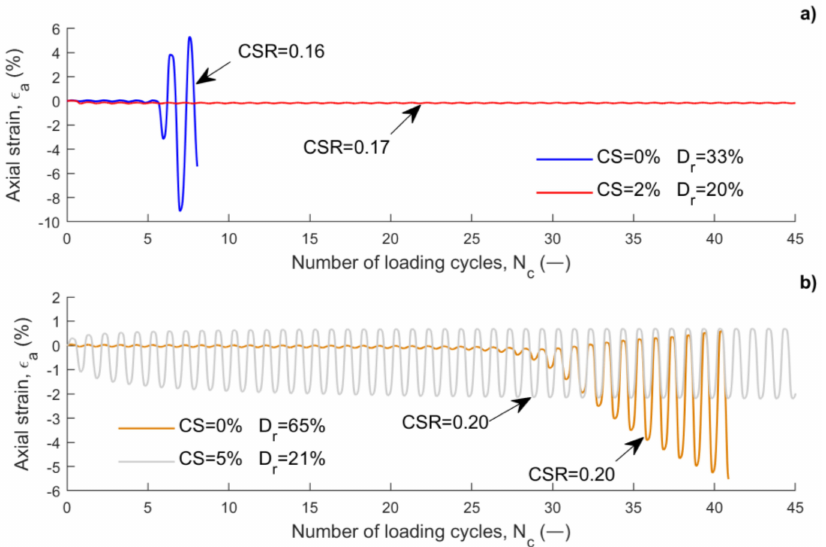
Figure 6. Axial strain versus number of loading cycles: ( a ) untreated and 2% CS-treated specimens; ( b ) untreated and 5% CS-treated specimens (mod. from [14]).